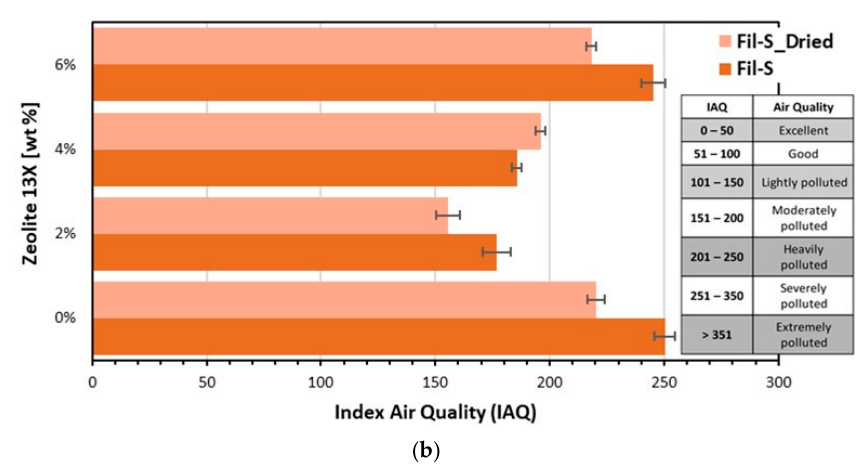
Figure 12. Index for Air Quality (IAQ) values for: ( a ) pre-dried and non-dried PW with different concentrations of Z310; and ( b ) pre-dried and non-dried Fil-S with different concentrations of 13X. In the case of PW-based composites, the lowest values of IAQ were measured at 4% of zeolite Z310 for both the dried and non-dried samples. For Fil-S-based systems, the minimum IAQ data were registered at 2% of zeolite 13X, even if, by increasing the zeolite content at 4%, the IAQ values were still included in the range corresponding to “moderately polluted” air, as for the specimens at lower zeolite amounts.